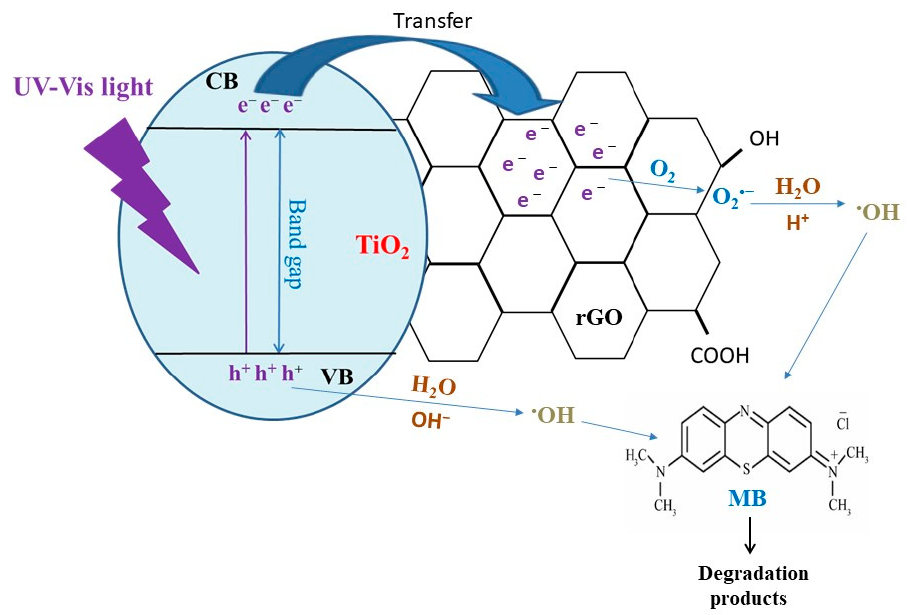
Figure 8. The photocatalytic mechanisms of rGO/TiO 2 nanocomposite for MB dye degradation.